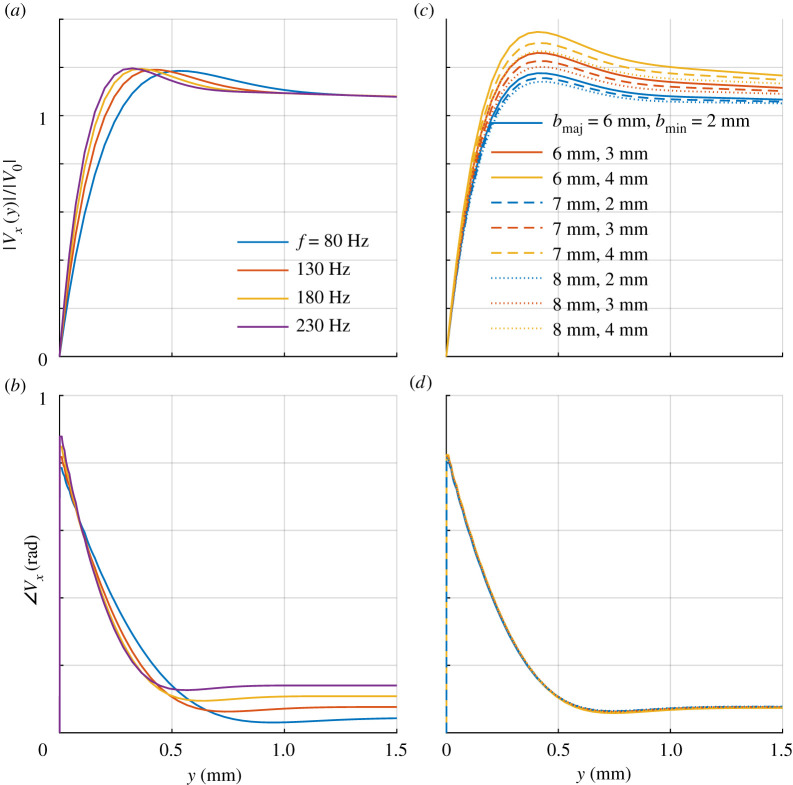
Normalized amplitude |Vx|/|V0| and phase ∠Vx of air flow along x against distance y from bee body surface. (a,b) For a fixed body geometry, ellipsoid with bmaj = 7 mm and bmin = 2.5 mm, the boundary layer flow is seen to vary with f. (c,d) Boundary layer flow variation with ellipsoid dimensions bmaj and bmin at f = 130 Hz.